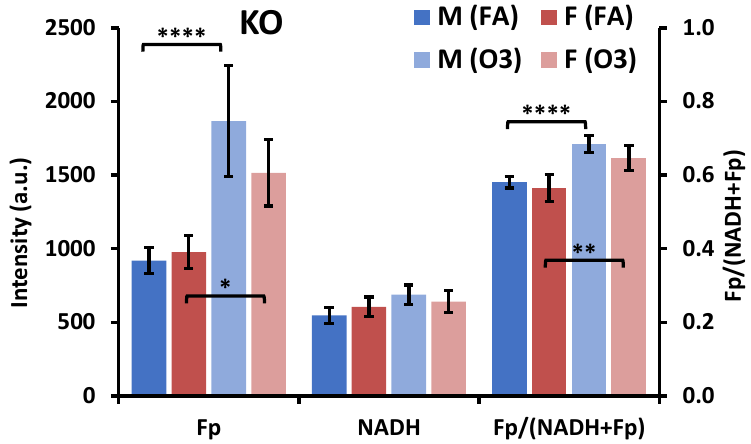
Figure 6. Sex-associated redox difference of AM in KO mice exposed to FA or O 3 (Mean ± SD). F- female; M-male. * p < 0.05, ** p < 0.01, and **** p < 0.0001.